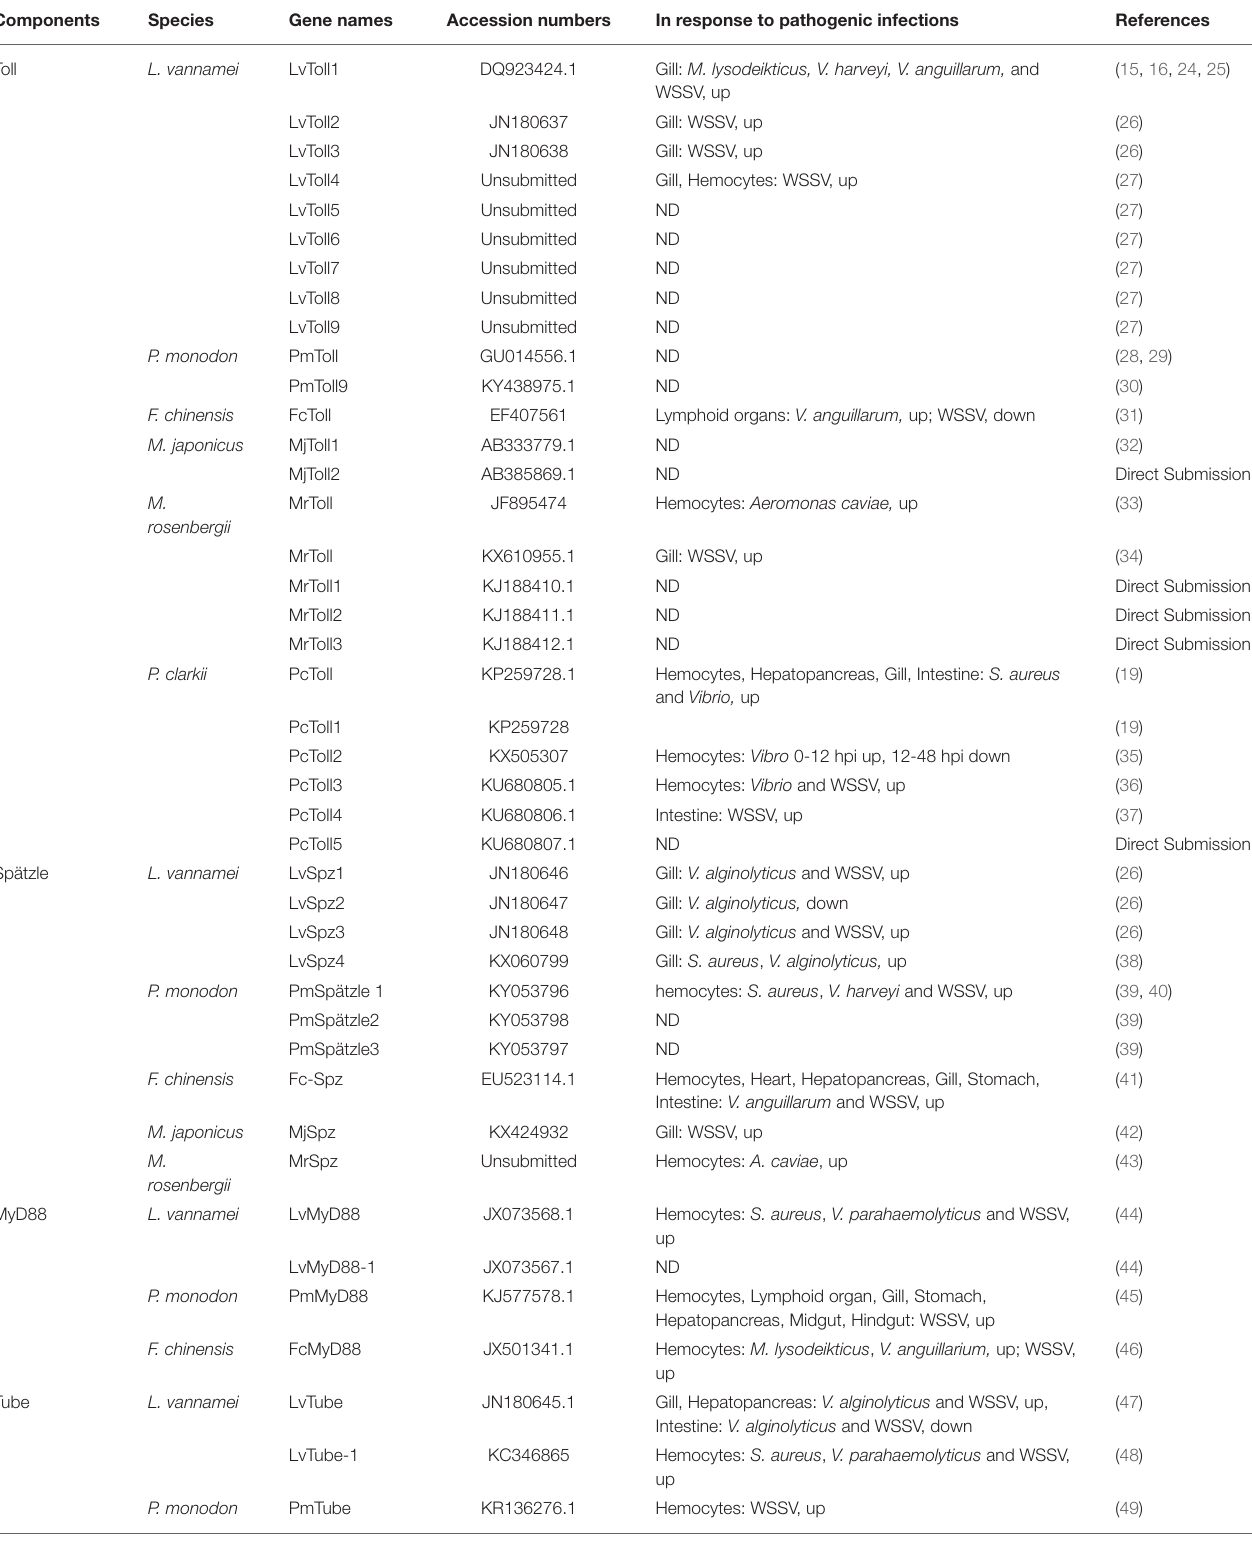
TABLE 1 | Components of canonical Toll signaling pathway identified in shrimps.